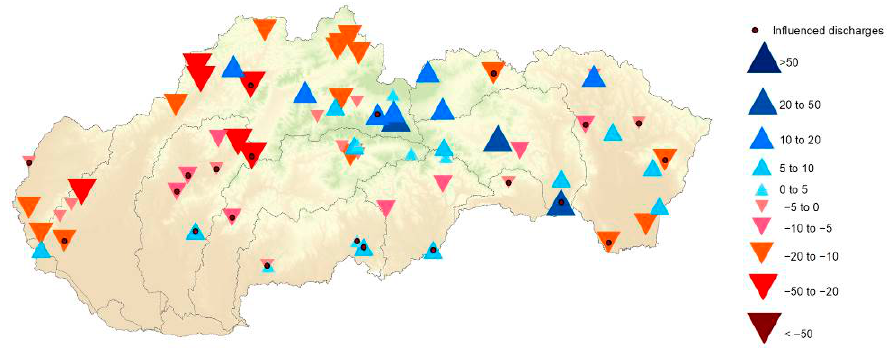
Figure 3. Changes in values of Q 330d from 2001–2015 vs. 1961–2000 (% of increase/decrease).